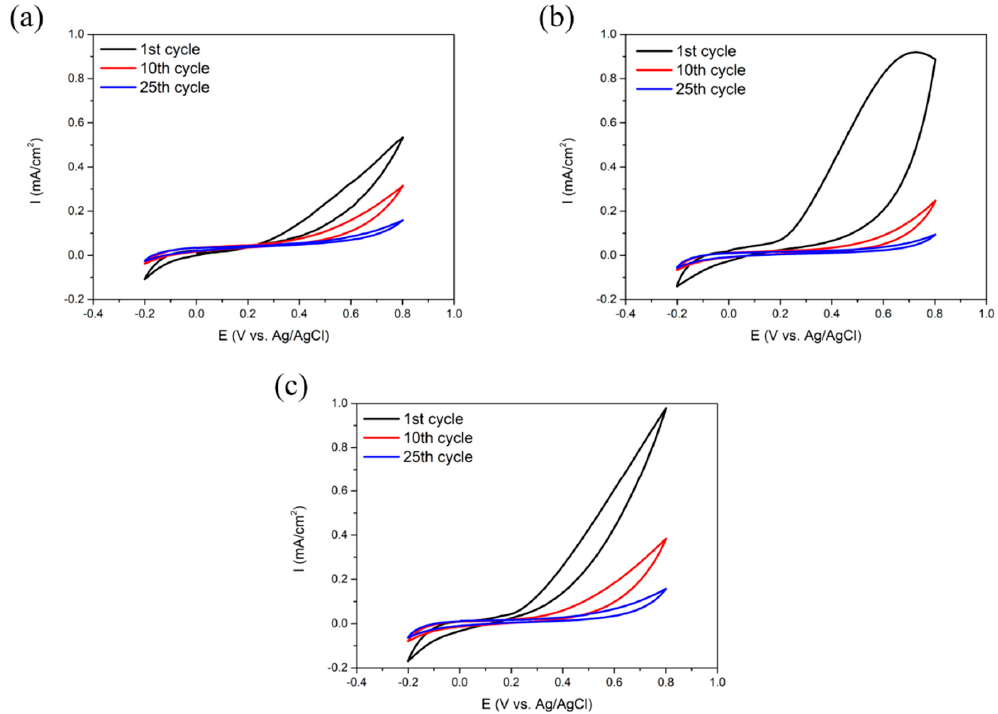
Figure 3. Cyclic voltammograms of SPAN deposited on a mild steel electrode using electropolymerization with AN/DABSA mole ratio of ( a ) 10 (pH = 6.24), ( b ) 8.8 (pH = 6.12), and ( c ) 3.4 (pH = 5.86) at a scan rate of 25 mV/s.